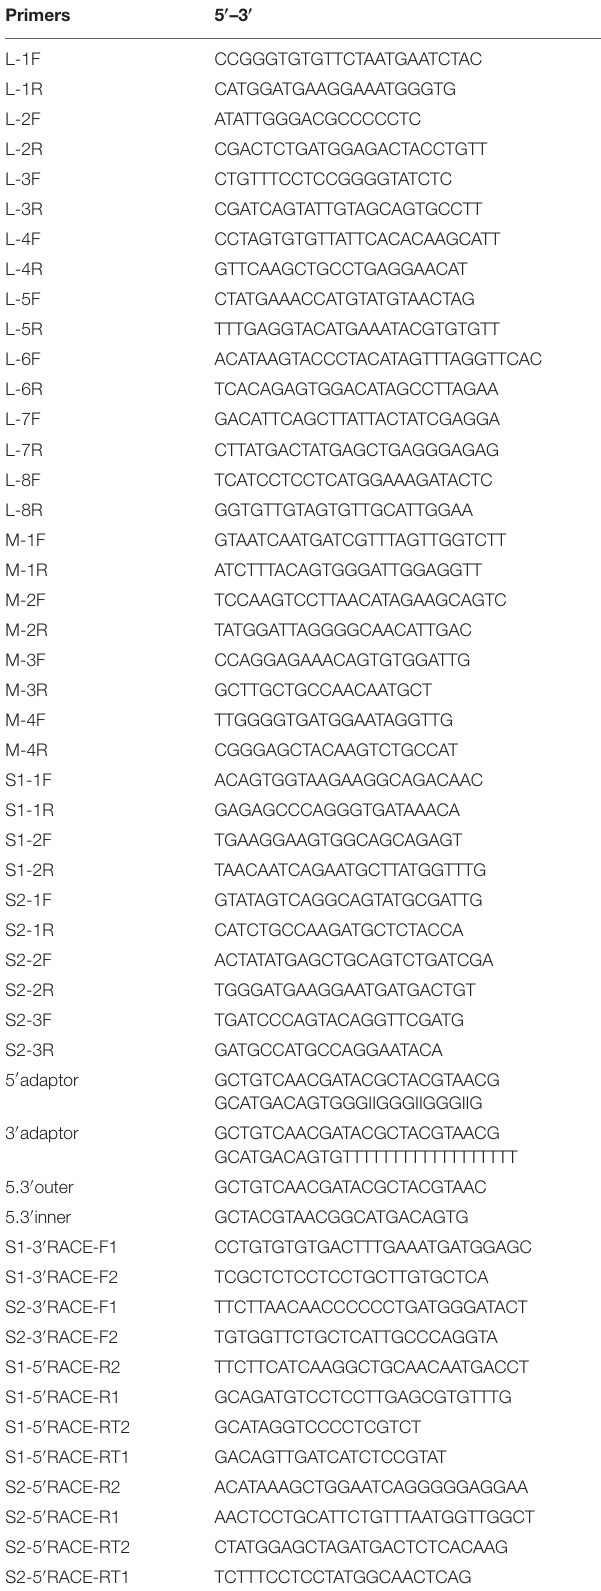
TABLE 1 | Primer sequences used for 5 (cid:48) -RACE, 3 (cid:48) -RACE, and PCR.